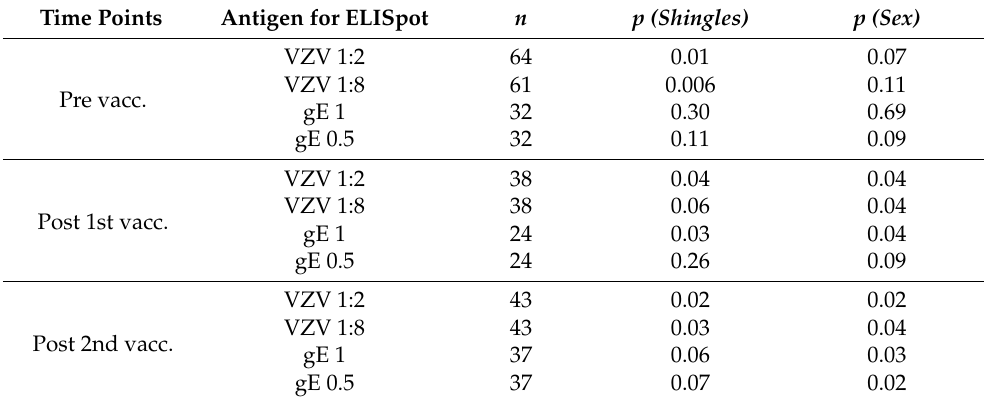
Table 2. Multivariate analysis of the impact of shingles and sex on VZV-specific ELISpot responses in patients after hematopoietic stem cell transplantation.